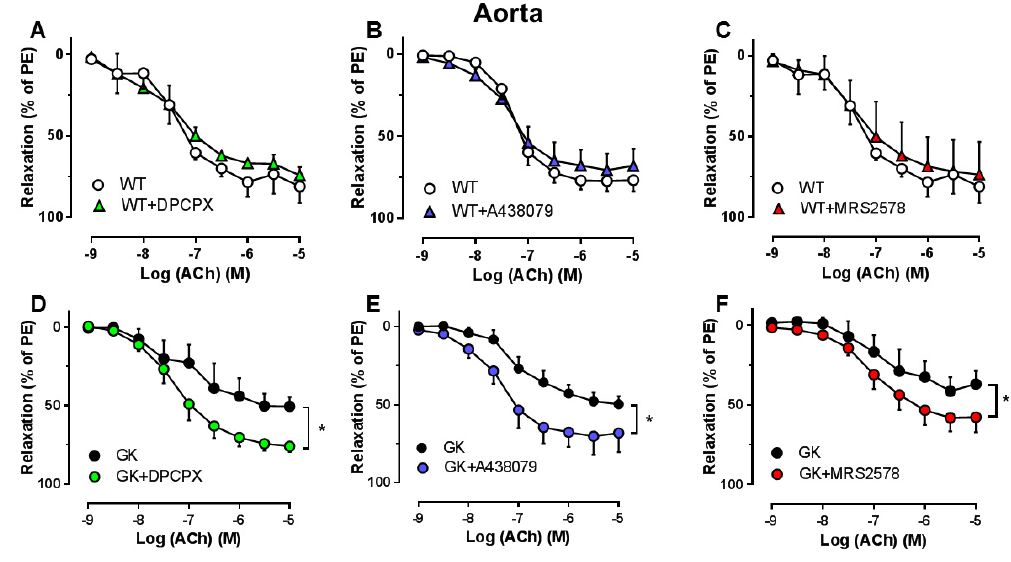
Figure 4. Effects of specific antagonism for A1R, P2X 7 R, and P2Y 6 R on EDR in aortas. Concentration–response curves for acetylcholine (ACh) in aortas preconstricted with PE in the absence and presence of the A1R antagonist (DPCPX, 10 − 8 M) ( A , WT n = 3; D, GK n = 7), the P2X 7 R antagonist (A438079, 10 − 5 M) ( B , WT n = 4; E, GK n = 10), and the P2Y 6 R antagonist (MRS2578, 10 − 5 M) ( C , WT n = 3; F, GK n = 8). Data are presented as mean ± SEM as percentage relaxation of PE. * p < 0.05 calculated with two-way ANOVA.